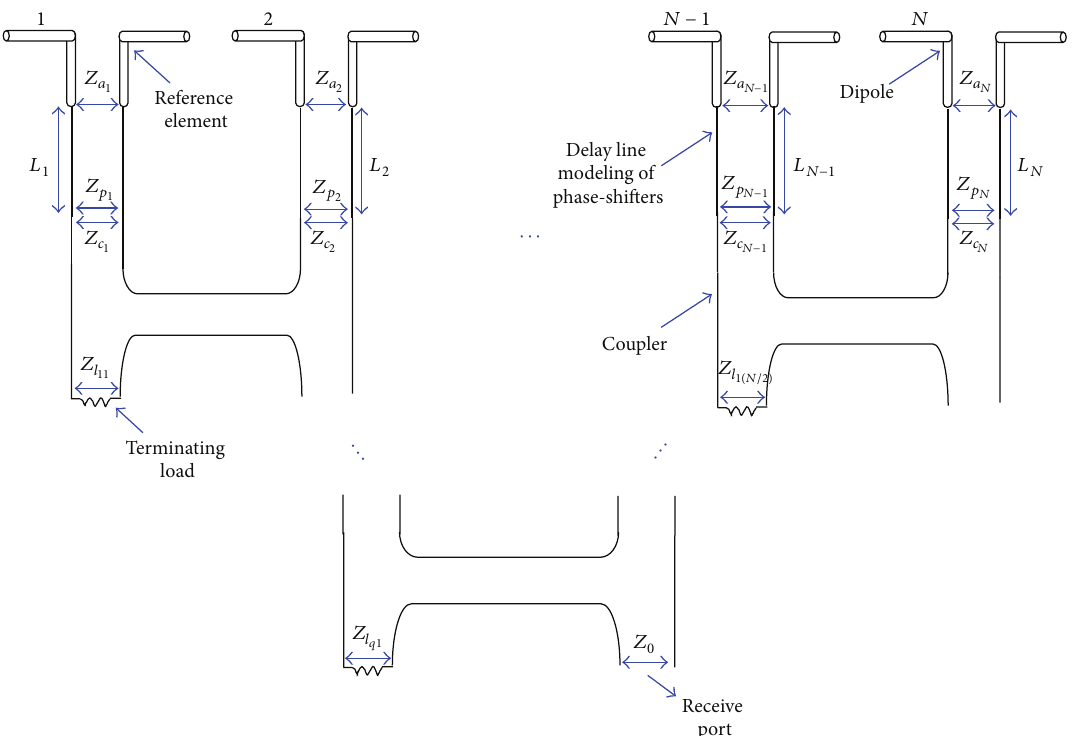
Figure 1: Typical parallel-feed network of dipole phased